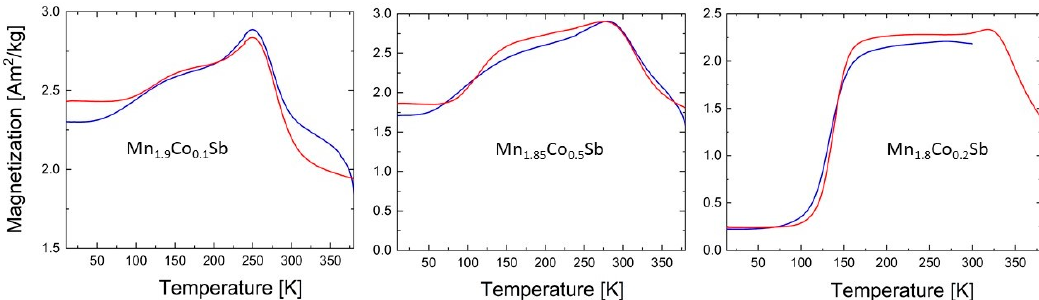
Figure 1. Temperature-dependent magnetization curves (M( T )) for the polycrystalline samples of Mn 1.9 Co 0.1 Sb, Mn 1.85 Co 0.15 Sb, and Mn 1.8 Co 0.2 Sb upon cooling (blue) and heating (red) in a constant magnetic field of µ 0 H = 0.01 T. Table 1. Magnetic phase transition temperatures T SF and T t in [K] for the Mn 2 − x Co x Sb ( x = 0.1, 0.15, 0.2) powder samples and the width of thermal hysteresis T hys for T t between the cooling and heating cycles. Transition Temperatures